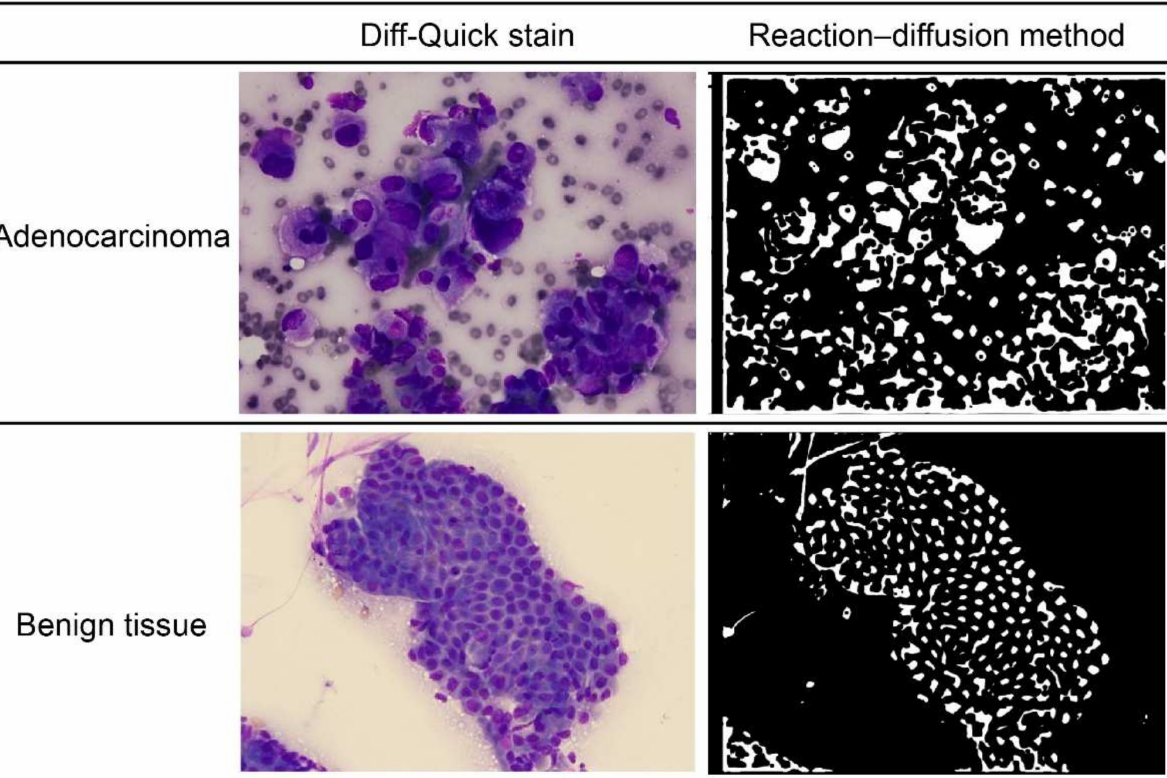
Figure 1. The left panels: Diff-Quick stain of adenocarcinoma and benign pancreatic tissue. The right panels: “reaction–diffusion method” of adenocarcinoma and benign pancreatic